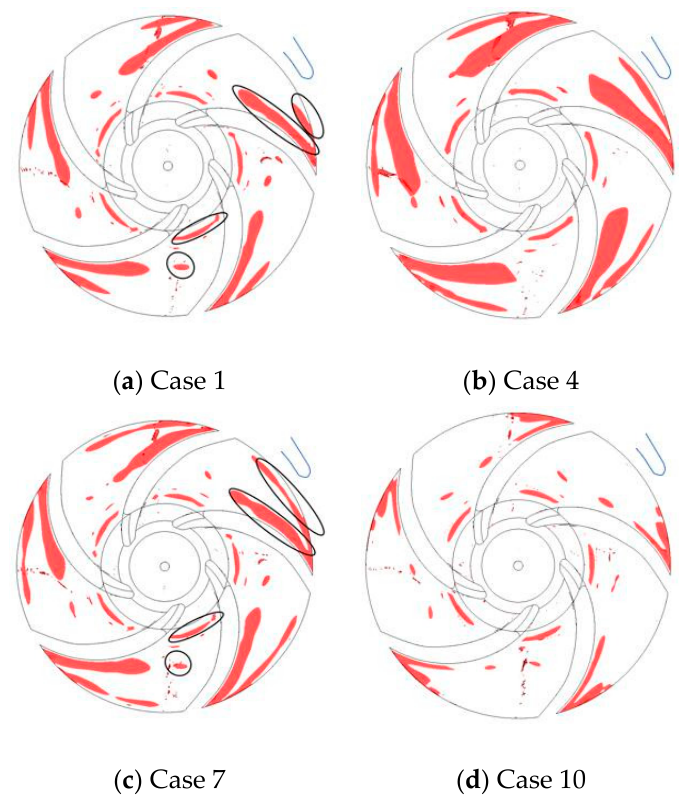
Figure 21. Distribution of the K values for ( a ) Case 1, ( b ) Case 4, ( c ) Case 7 and ( d ) Case 10 ( K max = 30).